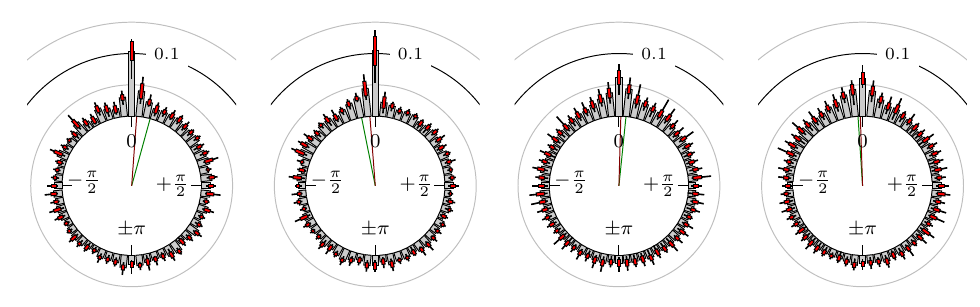
Figure 18. Gold versus EUR-USD.